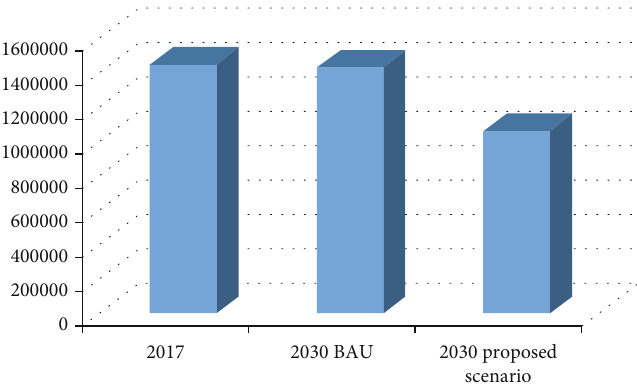
Figure 2: Greenhouse gas emissions by transportation sector of 2017, 2030 BAU, and 2030 proposed